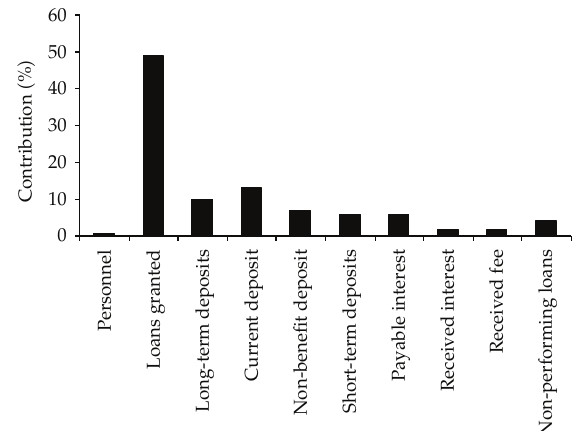
Figure 2: The relative contributions of di ff erent variables on the overlap in DEA-DA in example 1 that the real data set consists of 18 banking